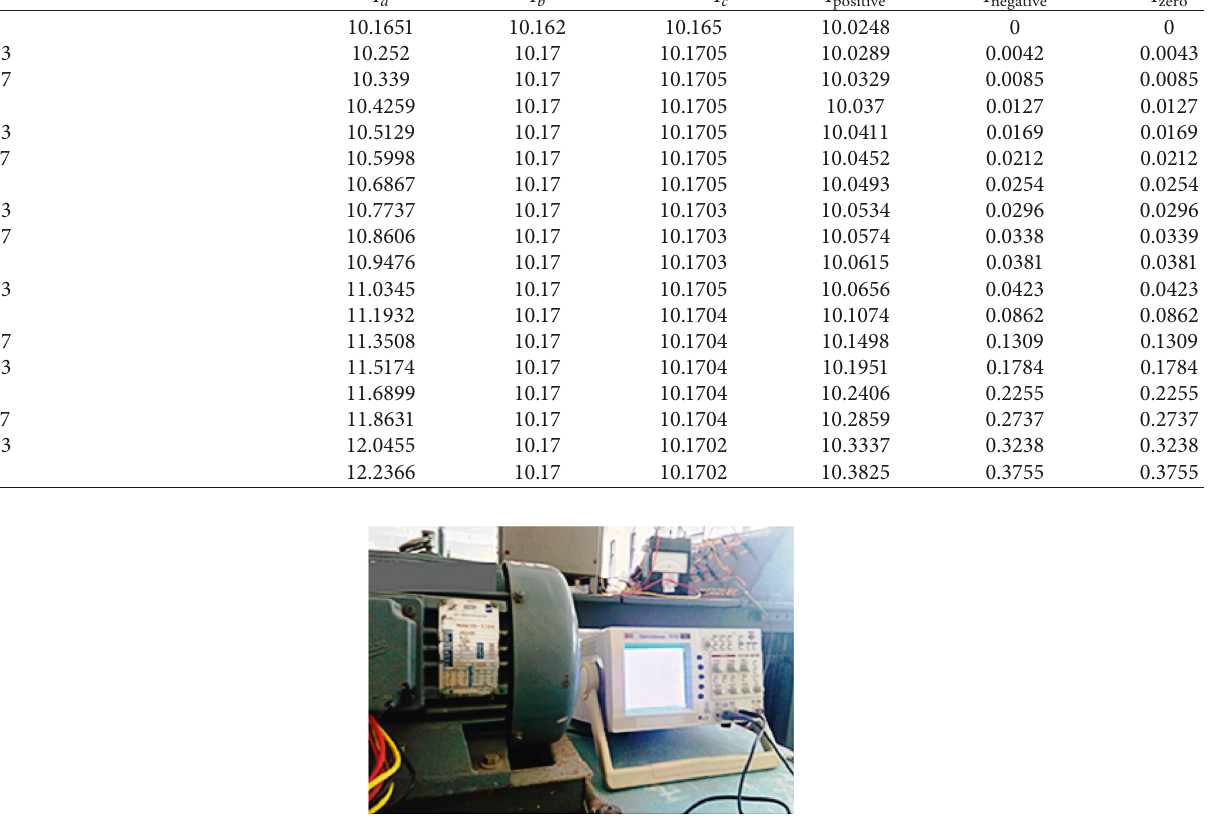
Figure 2: Experimental setup of 5 hp three-phase induction motor with interturn fault in one phase. Table 2: Comparison of phase current values of 5hp motor obtained from simulation and experiment.